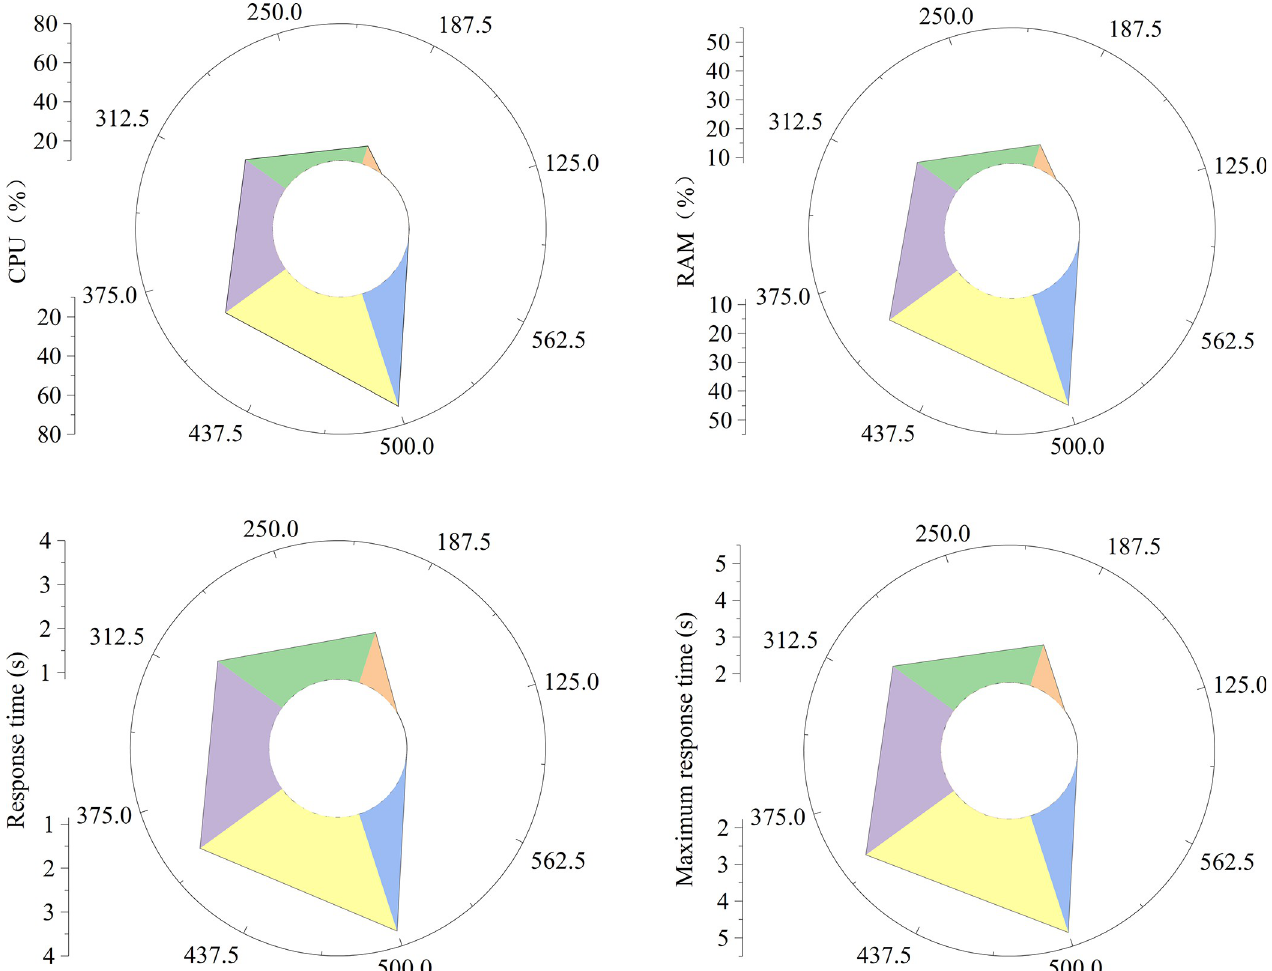
Fig 12. The data graphs for user load